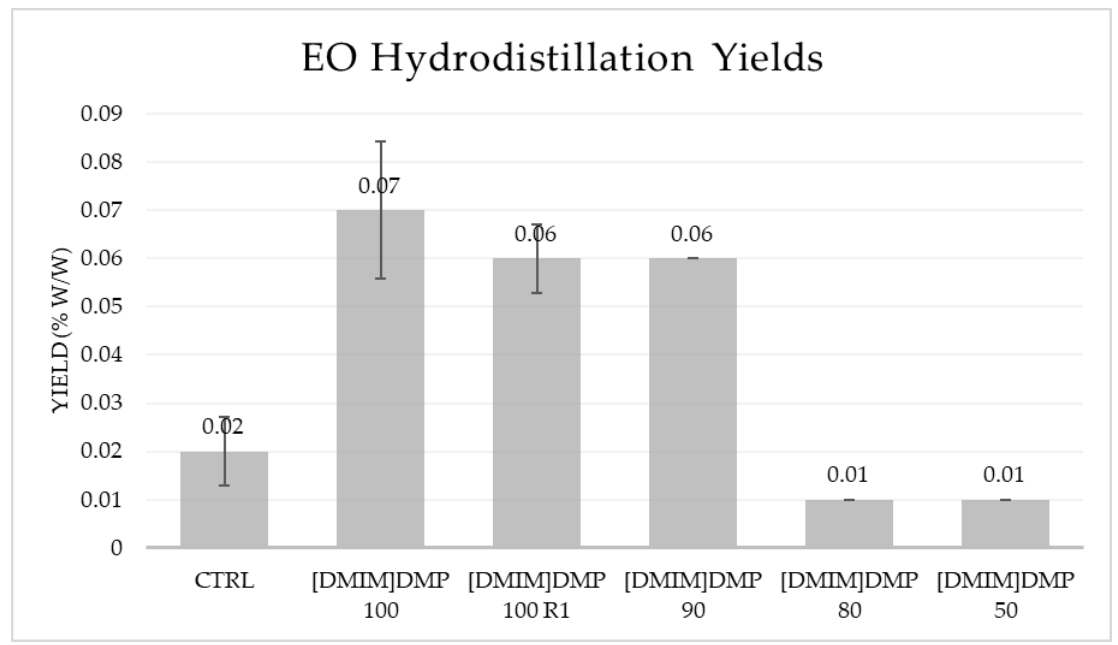
Figure 3. EO hydrodistillation yields (indicated as % w / w , vertical bars represent the standard deviations) of all